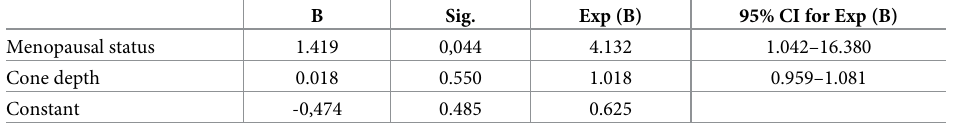
Table 4. Logistic regression analysis for the presence of residual lesions at hysterectomy (dependent variable: residual disease, independent variables: menopausal status and cone depth). B